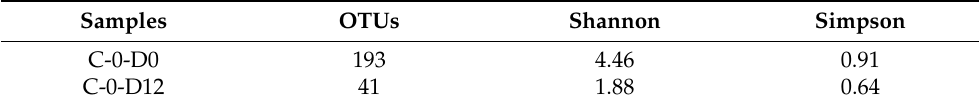
Table 2. Alpha diversity of bacterial flora for crawfish stored at 4 ◦ C in vacuum package.